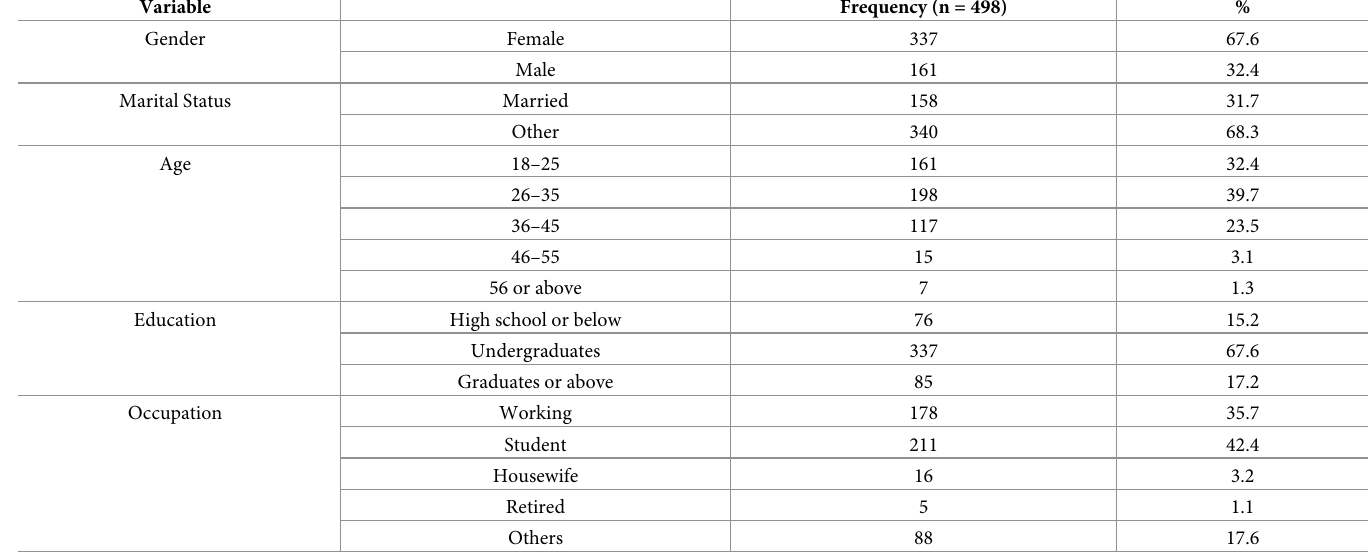
Table 1. The demographic profile of